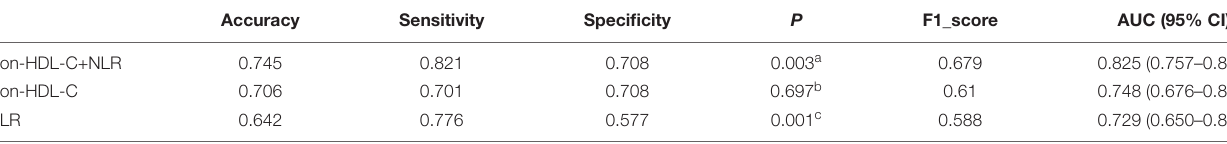
TABLE 3 | Predictive value of different lipid indicators for vulnerable plaques.